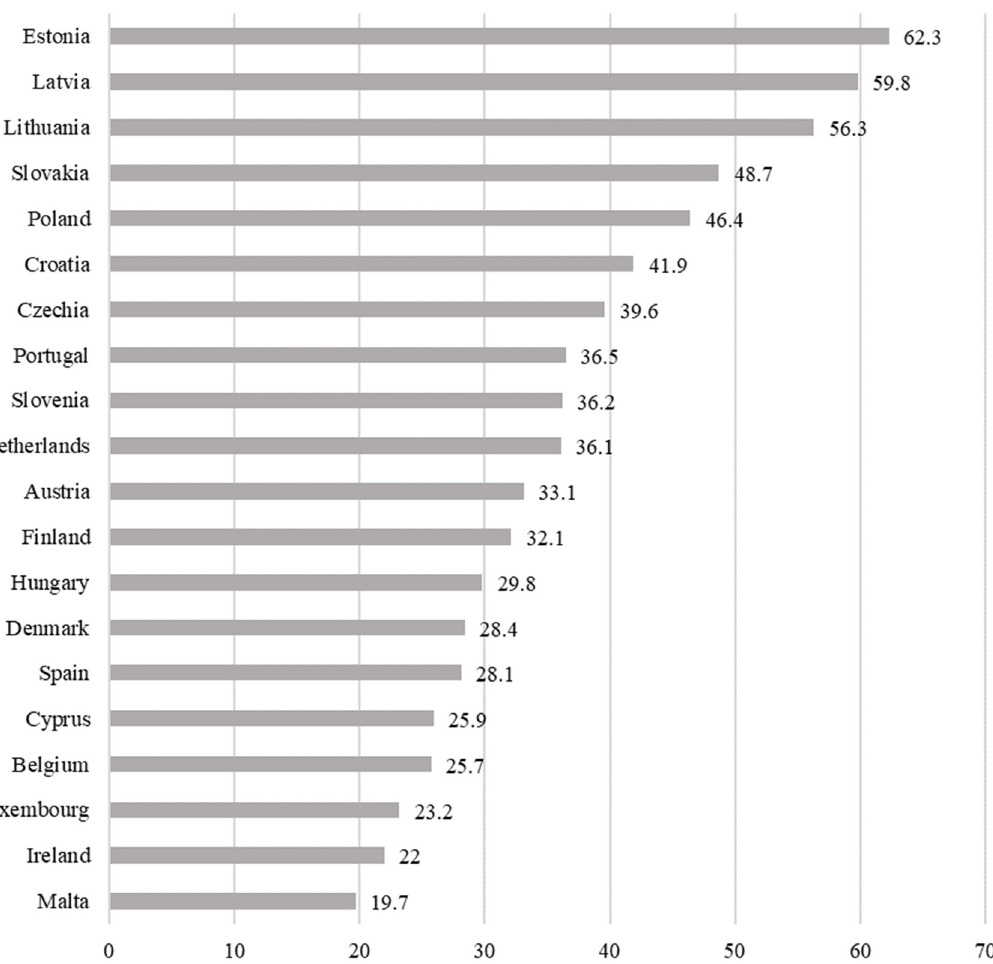
Figure 2. People having a long-standing illness or health problem, foreign population, European Union countries (EU28), 2020 (%). Source: Eurostat—last data extracted on 5 December 2021 (online data code: HLTH_SILC_25).